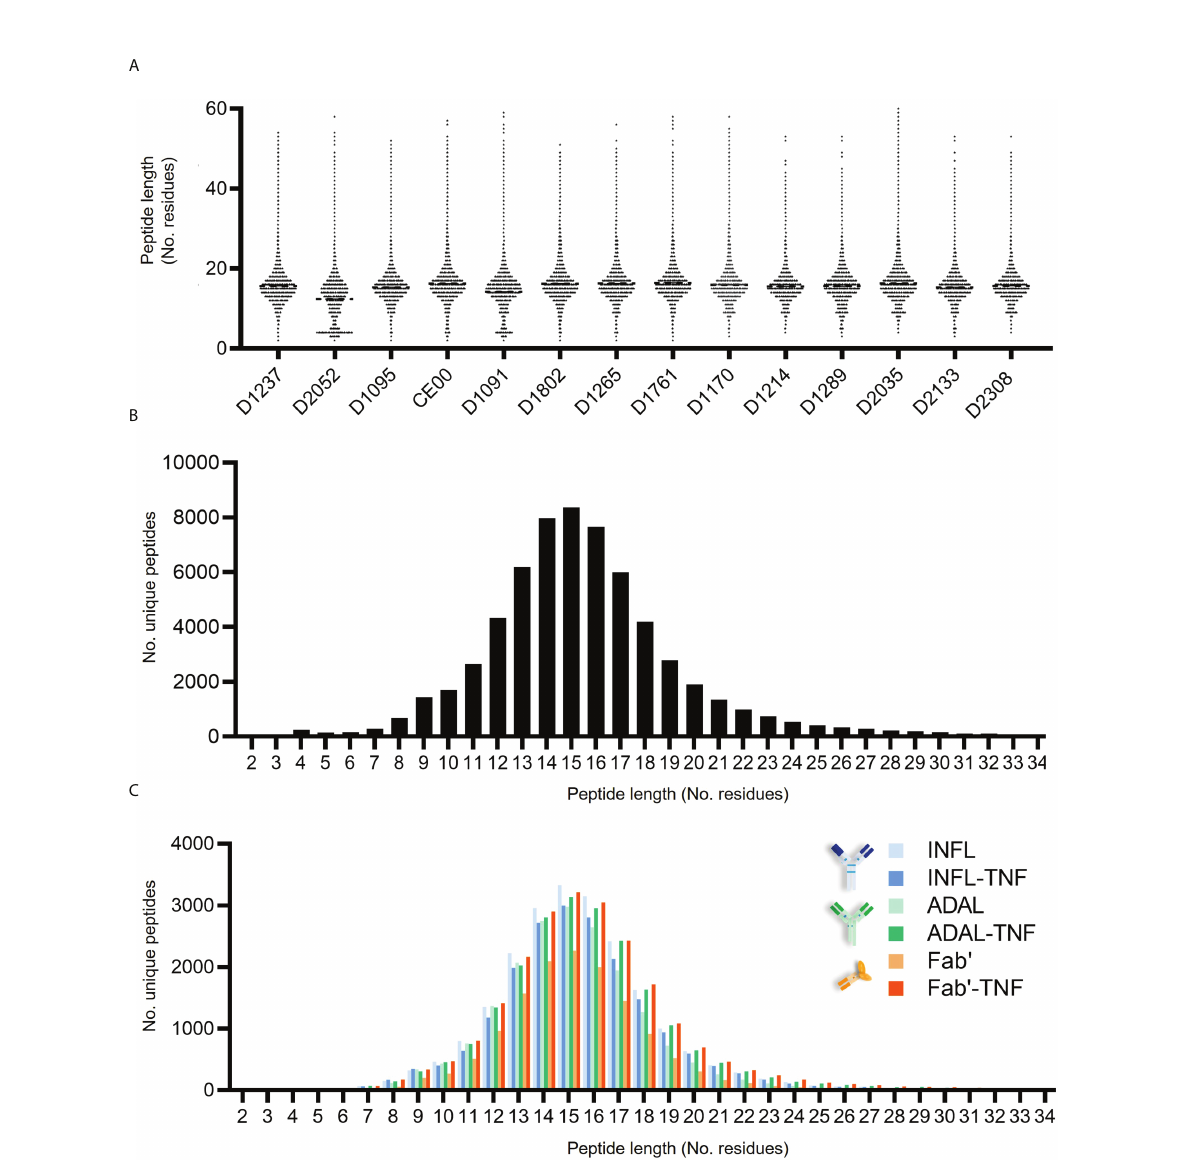
FIGURE 6 HLAII-presented sequences derived from anti-TNF compounds identi fi ed by HLAII immunopeptidomics. (A, B) Sequence coverage of identi fi cation within both light chain (LC) and heavy chain (HC) from antagonists detected in HLAII immunopeptidomes from antagonist-treated sets corresponding to INFL (blue) ADAL (green) and Fab ’ (orange) (C) Length distribution of identi fi ed TNF antagonist-derived peptides from all